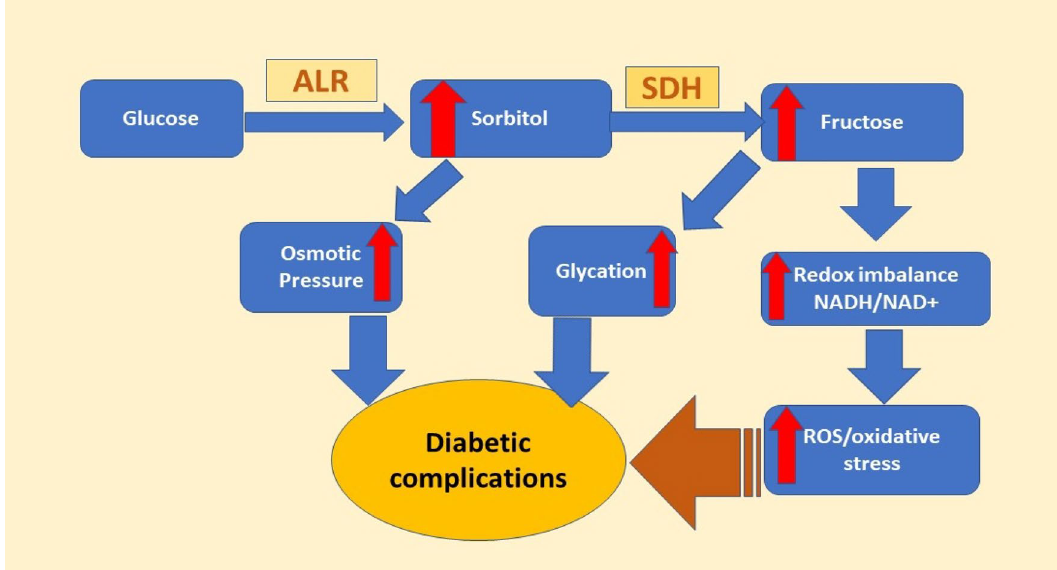
Figure 1. The polyol pathway. Abbreviations: ALR aldose reductase, SDH sorbitol